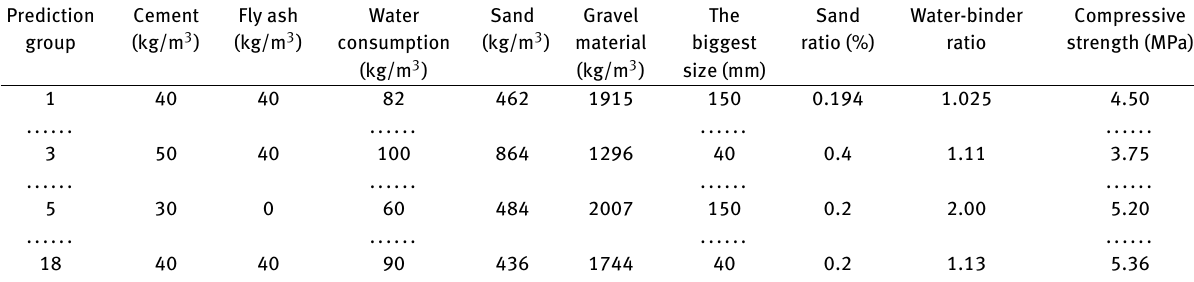
Table 4: BP neural network prediction sample data Prediction